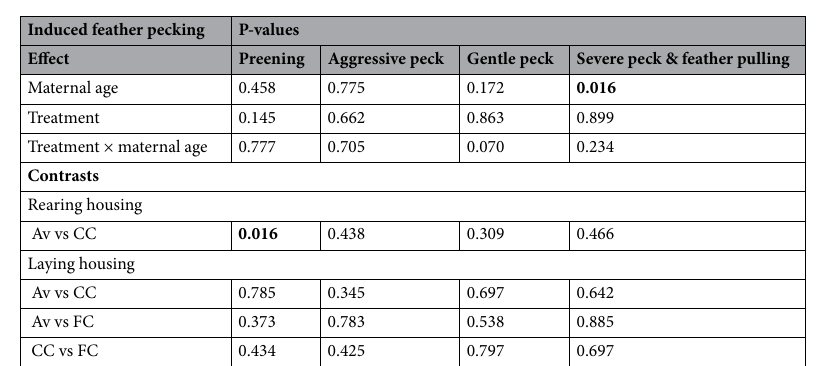
Table 4. Social feather pecking test. Effects of maternal age, treatment and treatment by maternal age on preening, aggressive peck, gentle peck and severe peck and feather pulling, followed by contrast comparisons of rearing and laying environments. P-values less than 0.05 are